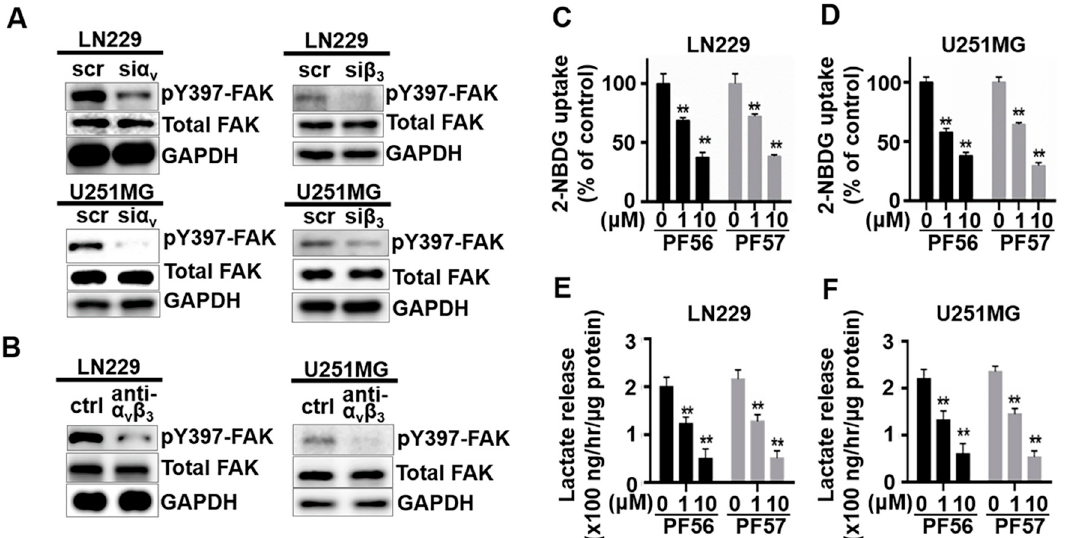
Figure 3. Focal adhesion kinase (FAK) inhibition reduces glucose uptake and lactate acid production. LN229 and U251MG cells were plated on osteopontin and ( A , B ) FAK activation is decreased in response to siRNA mediated knockdown of α v or β 3 when compared to that in cells treated with a control/scrambled siRNA (scr), or in cells treated α v β 3 blocking antibody when compared to cells treated with control isotype antibody (ctrl). ( C , D ) cells were then treated without or with PF562271 (PF56) or PF573228 (PF57), two FAK specific inhibitors at the indicated doses. Uptake of glucose analog 2-NBDG was reduced in cells treated with PF56 or PF57. ( E , F ) Lactate acid production in the culture medium was decreased in cells treated with FAK inhibitors PF56 or PF57. All experiments were repeated at least three times. Data are represented as mean ± SE, ** p < 0.01.